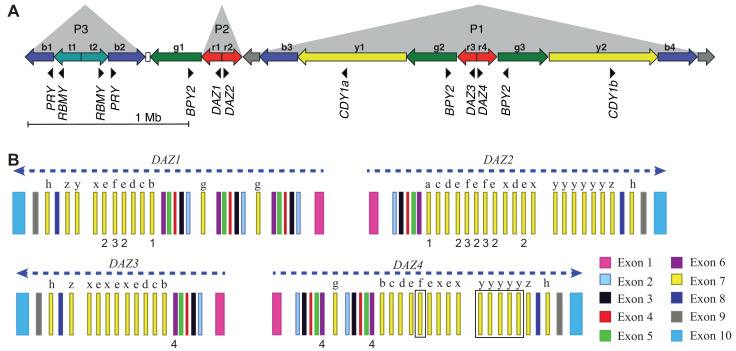
Location of the identified exonic variants in the DAZ genes.(A) Schematic representation of the human Y-chromosomal reference sequence containing the AZFc region, with approximate locations of protein-coding genes and their direction of transcription shown as black triangles. Direct and inverted repeats with highly similar DNA sequences are denoted as coloured arrows. (B) The structure of human DAZ genes, modified from Fernandes et al., 2002 to represent the human Y-chromosomal reference sequence (GRCh38). Blue dashed arrows show the direction of transcription. Exons with high DNA sequence similarity within and between DAZ genes are denoted with the same fill colour. The number of highly similar exon seven copies (in yellow) varies between genes and copies marked with the same letter denote identical sequences. Numbers below the gene structure denote exonic variants. 1 – DAZ1 p.H173Y or DAZ2 p.H173Y. 2 – DAZ1 p.Q262E or DAZ2 p.Q262E. 3 – DAZ1 p.Y243C or DAZ2 p.Y219C. 4 – potential splicing variant in DAZ3 or DAZ4. Black squares in DAZ4 denote the deleted exons 7f and 7y in Y lineages I1 and R1a1a1b1a2, respectively.